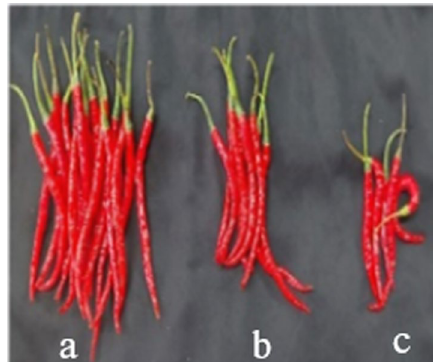
Fig. 3 Comparison of the number of chilies introduced by actinobacteria isolates with mancozeb and control at the